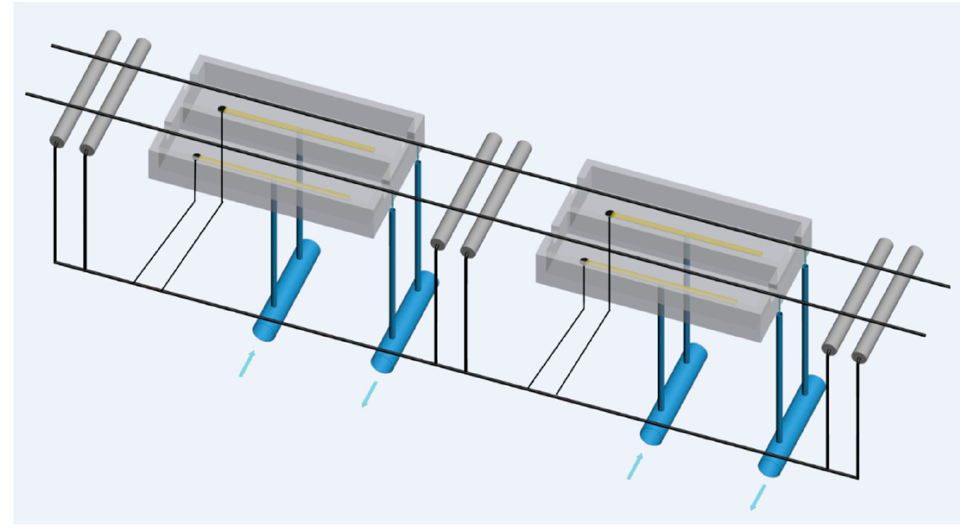
Figure 18. Schematic diagram of the CPA electroplating process. Reprinted with permission from ref. [28].